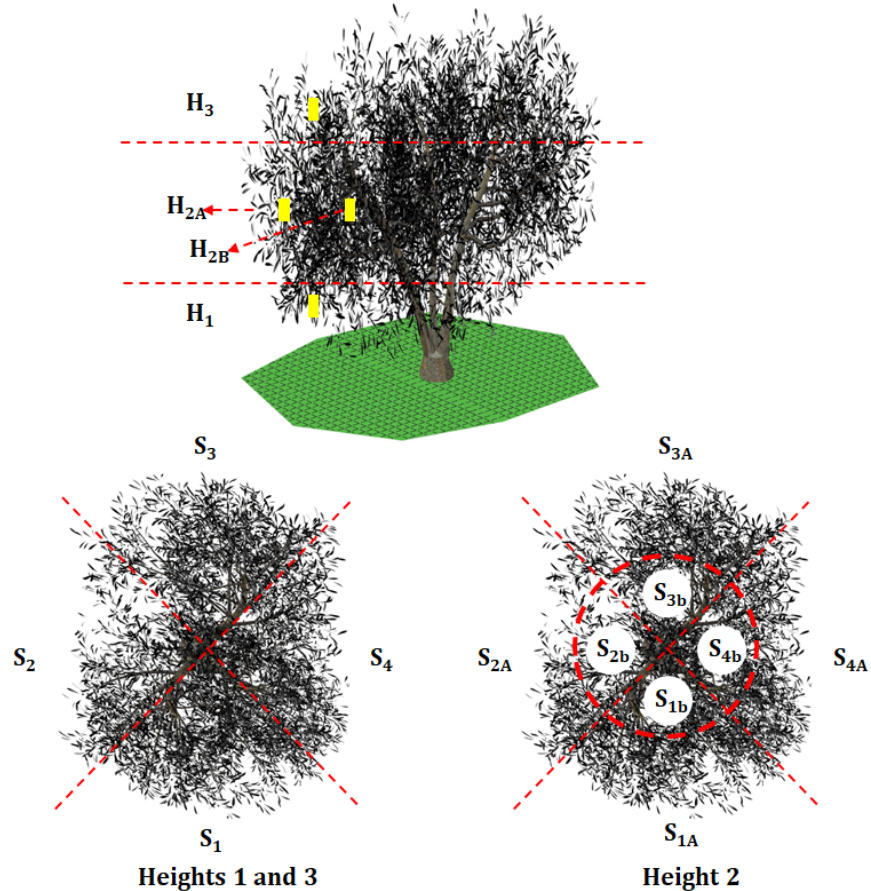
Figure 4. Sampling positions to measure spray deposit and coverage. A total of four sectors (S 1 –S 4 ), with three sampling heights (H 1 –H 3 ) and two sampling depths in the intermediate height (H 2A and H 2B ) made a total of 16 sampling positions.